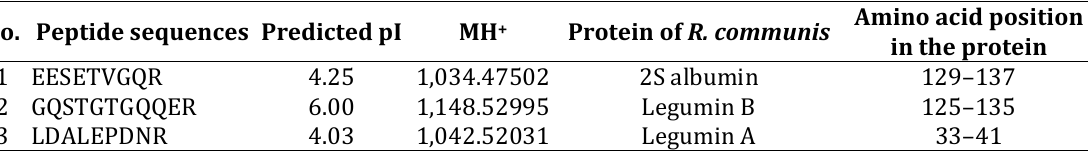
No. Peptide sequences Predicted